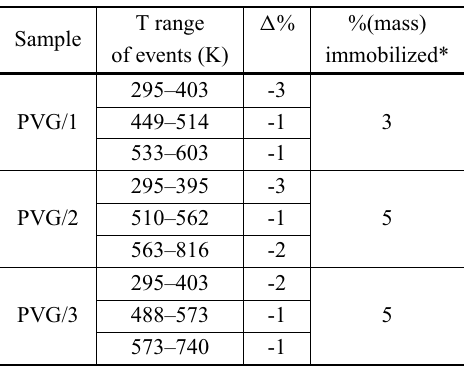
Thermogravimetric data for samples PVG/ 1-3